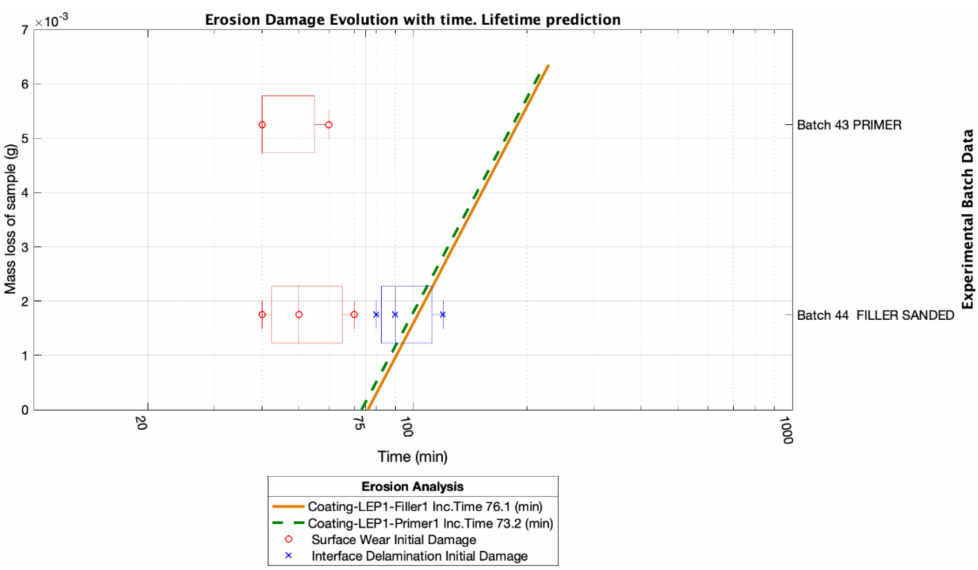
Figure 7. Rain erosion testing lifetime analysis for experimental tested and simulated material LEP configuration comparing coating LEP configuration with No-primer layer (application directly to the filler), and coating LEP configuration with intermediate primer layer.